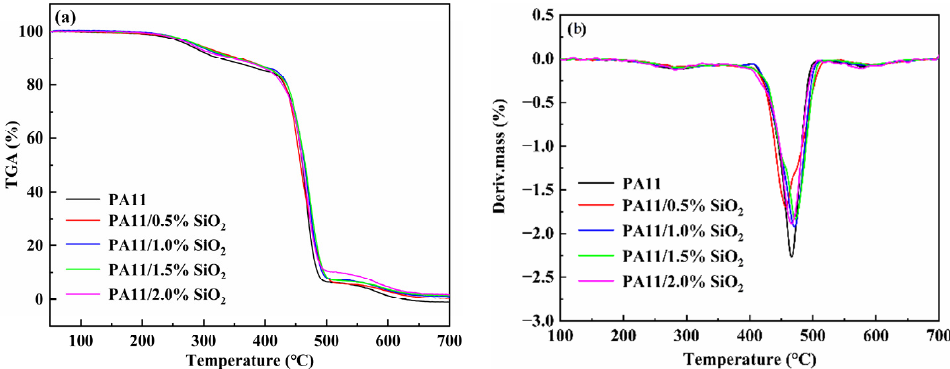
Figure 10. TGA curves ( a ) and DTG curves ( b ) of neat PA11 and PA11/SiO 2